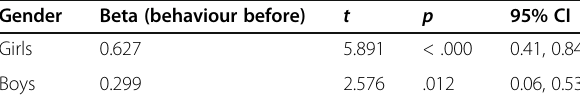
Table 4 Conditional effects of social function before orthodontic and surgical treatment on social function after treatment depend on